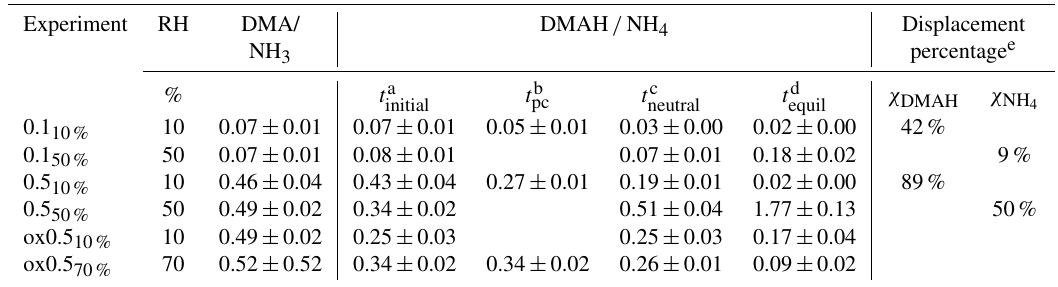
a The neutralisation ratio is defined as the number of moles of alkaline species over moles of acidic species, X = (DMAH + NH X = (DMAH + NH 4 )/ C 2 O 4 . b For co-uptake experiments X maxneutral describes the maximum neutralisation ratio of particles before reaching equilibrium. Table 2. Comparison of DMA / NH 3 (gas) molar ratios at different RH and DMAH / NH 4 (particle) ratios at different times ( t ), as well as the displacement percentage ( χ ) for DMAH (10% RH) and NH 4 (50% RH) are